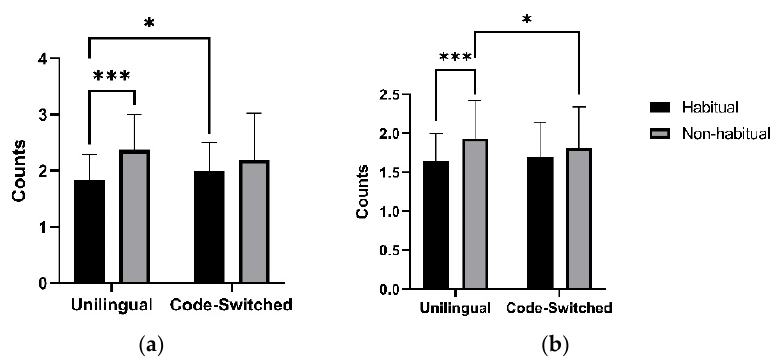
Figure 3. Comparison of ( a ) the fixation count and ( b ) the visit count. *** = p < 0.001, * = p < 0.05.